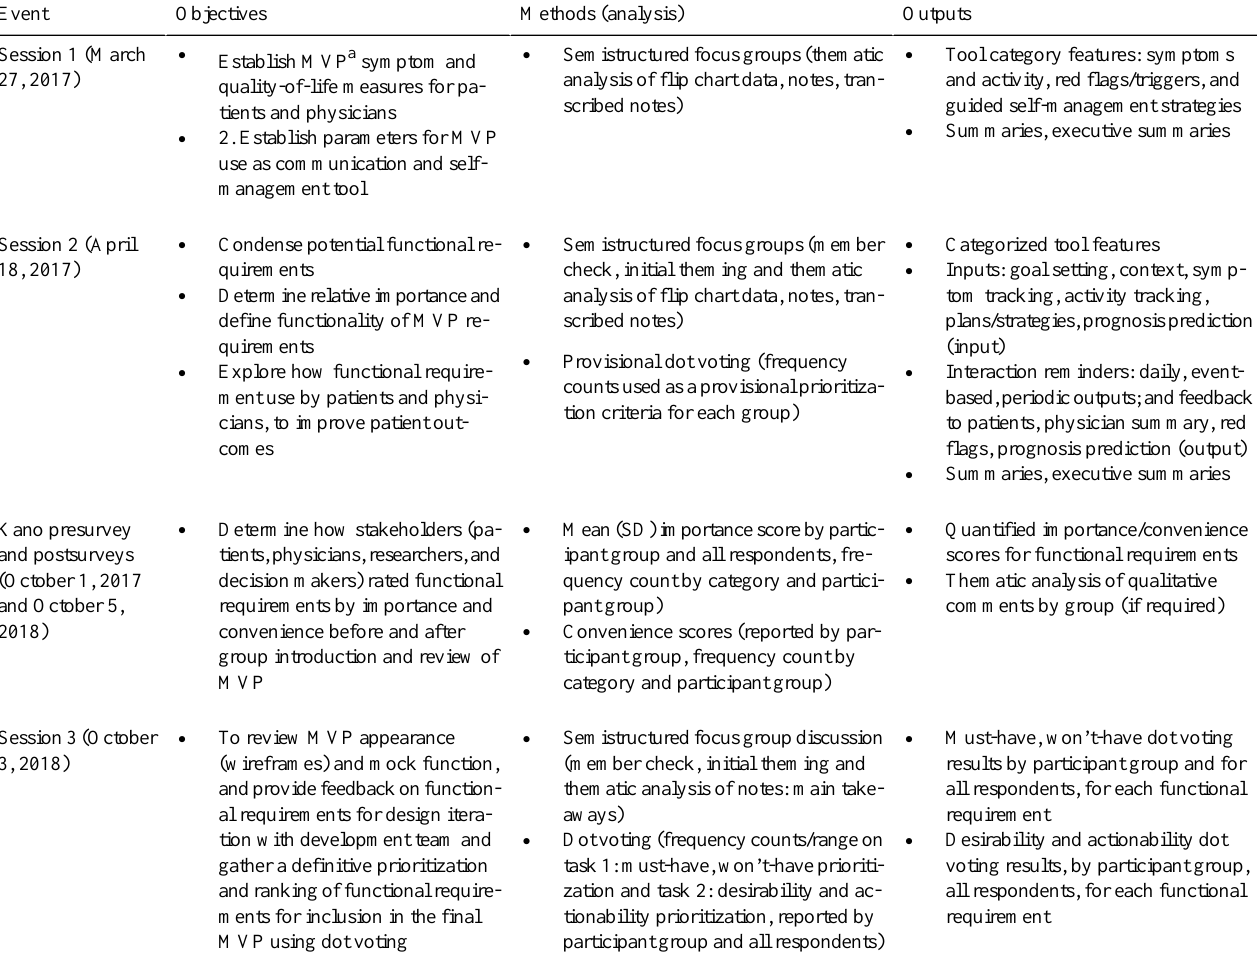
Table 1. Co-design session objectives, methods, and